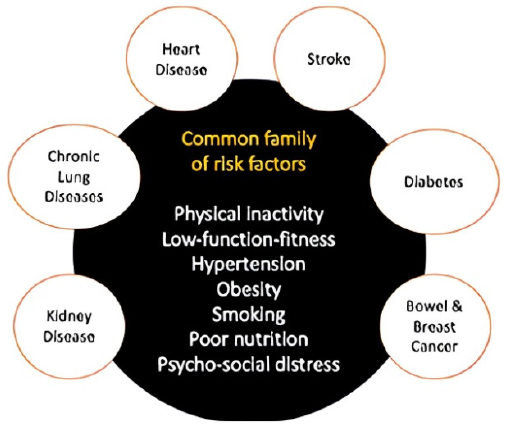
Figure 1. The consequences of physical inactivity[9]. (Source: Buckley, 2021)